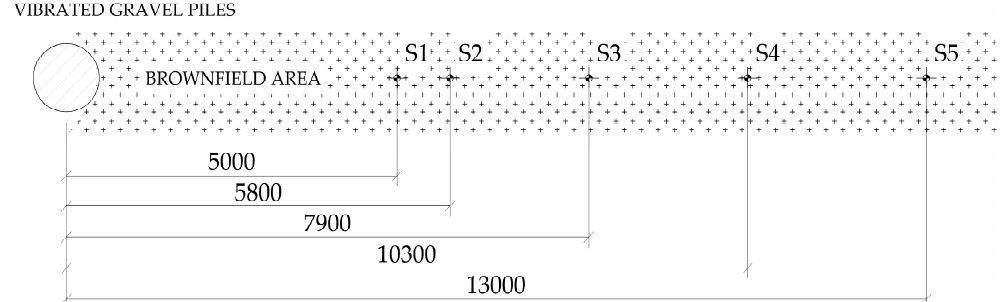
Figure 4. Measurement situation—vibrated gravel piles.